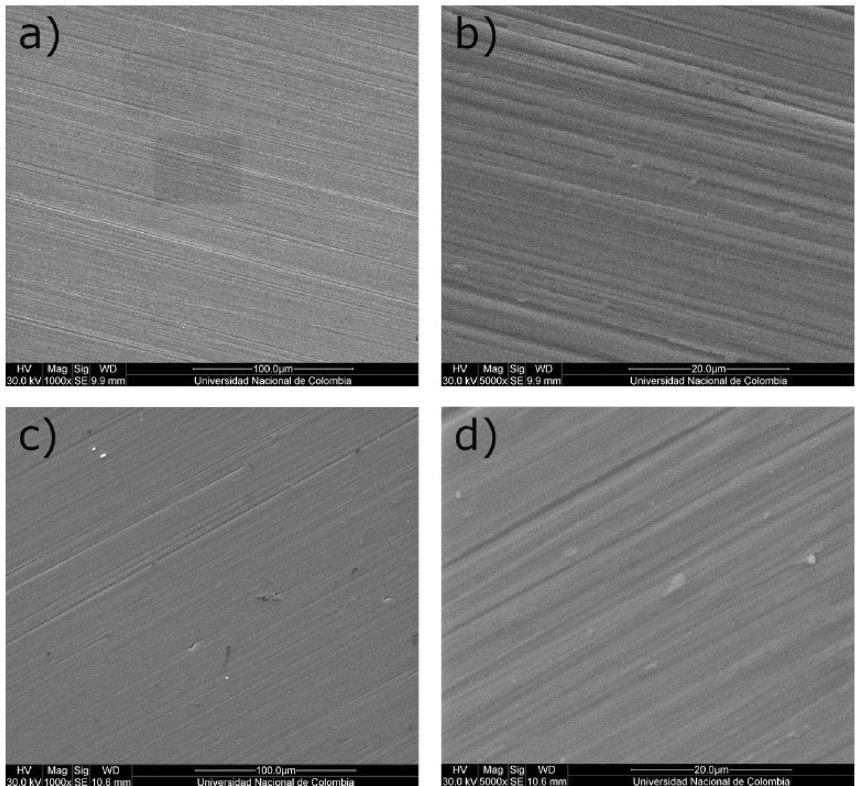
Figure 10. SEM micrograph showing the morphology of the ZrO 2 -ZrO x N y -316L coatings ( a , b ) before corrosion; ( c , d ) after corrosion in 3.5 wt. % NaCl solution.